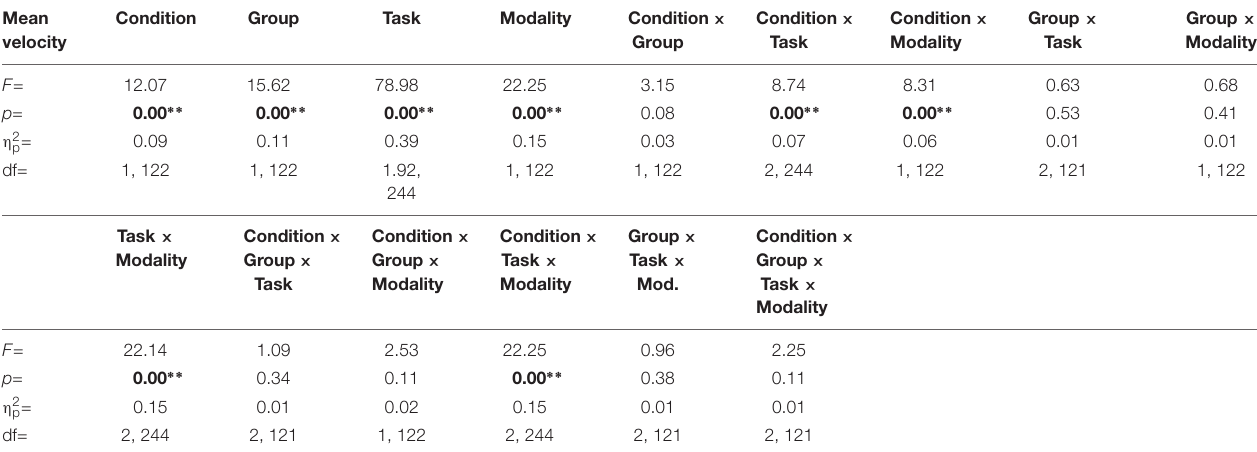
TABLE 1 | ANOVA results for mean velocity